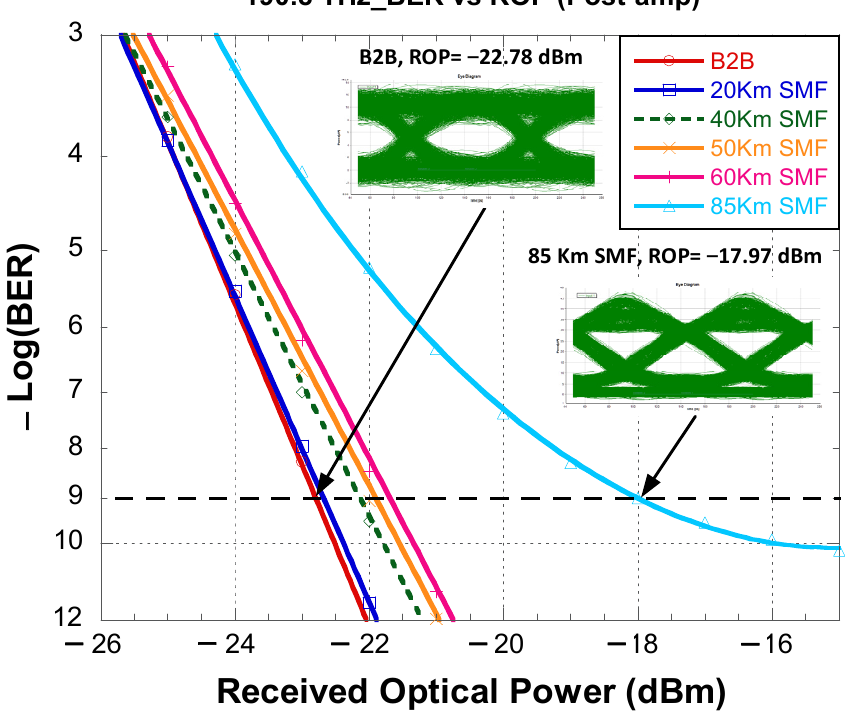
Figure 15. BER curve of CH1 (190.8 THz).